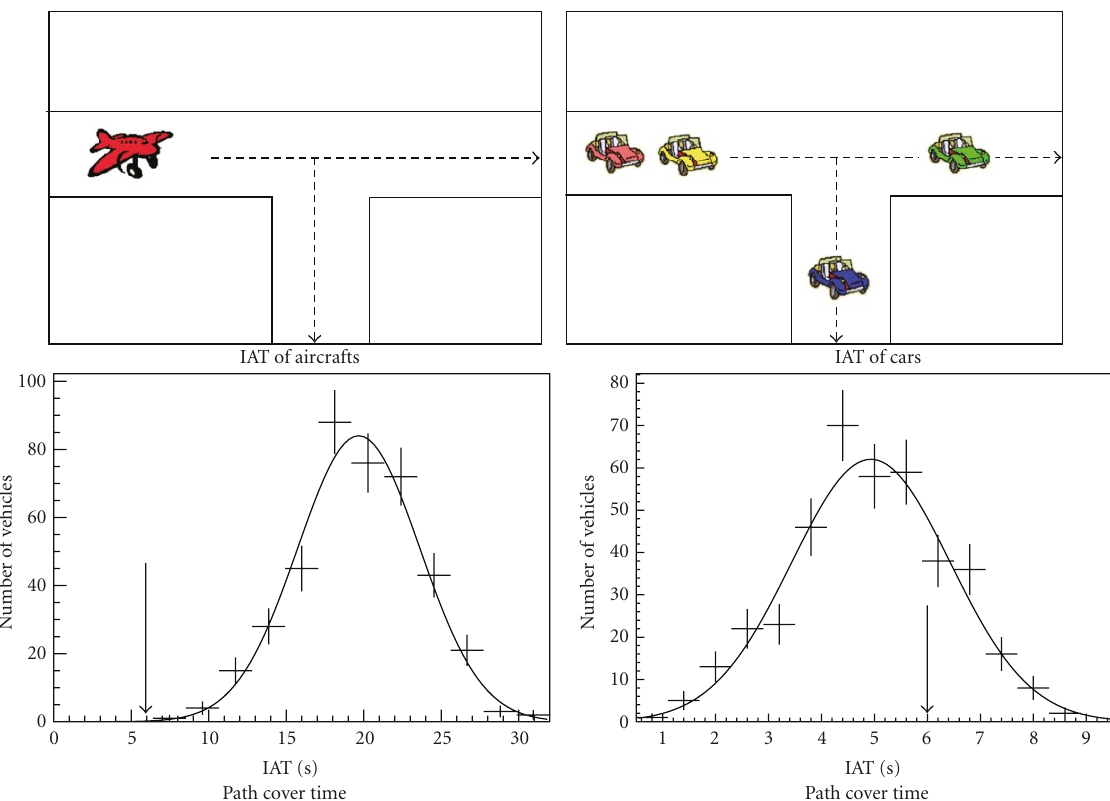
Figure 23: The Inter Arrival Time (IAT) distribution of vehicles in the taxiway and parking scenarios. The (fixed) path cover time is superimposed in the